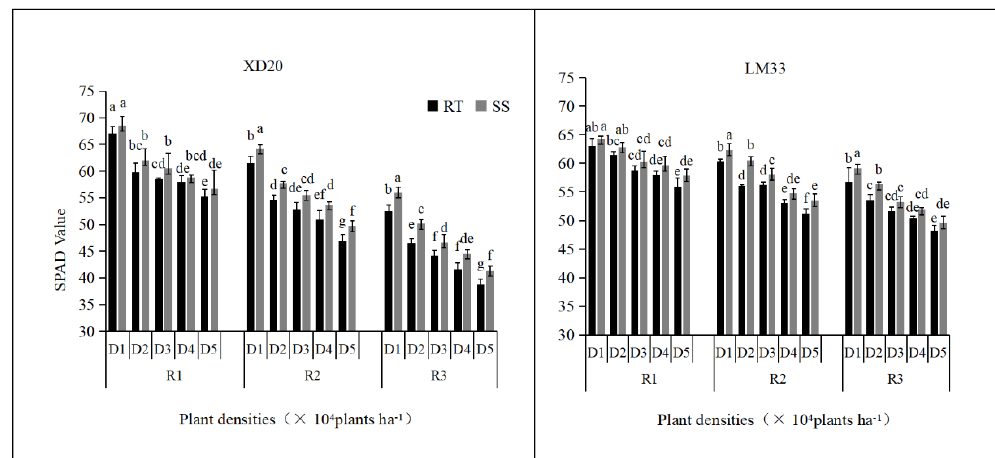
Figure 5. Relative chlorophyll content (SPAD) values of high-yielding spring maize under different tillage methods and planting densities. Different letters on the graph indicate significant differences at p < 0.05.